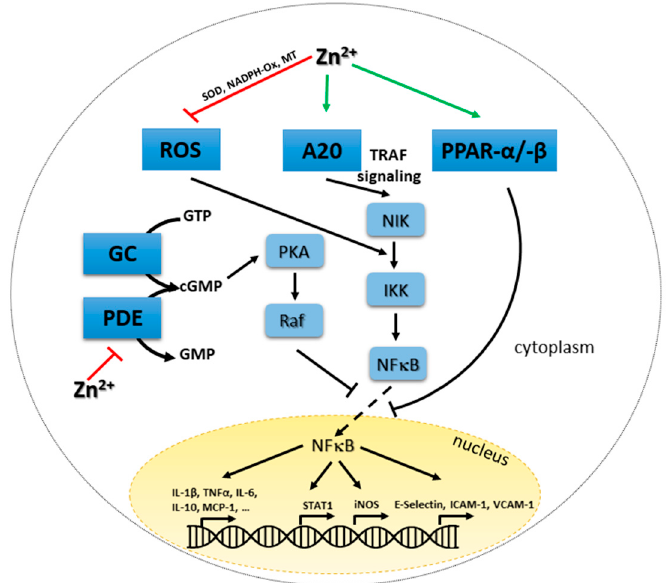
Figure 2. Complex impact of zinc on NF κ B-centered signaling as illustration of signaling pathways described in the text. Red T bar: inhibitory function of zinc, green arrow: activating function of zinc, black T bar: inhibition, black arrow activation. Abbreviations: cGMP: cyclic guanine monophosphate; GC: guanine cyclase; GMP: guanine monophosphate; GTP: guanine triphosphate; ICAM: intercellular adhesion molecule; iNOS: inducible nitric oxide synthase; IKK: I κ B kinase; IL: interleukin; MCP: monocyte chemoattractant protein; NIK: NF κ B-inducing kinase; NF κ B: nuclear factor (NF) κ B; PDE: phosphodiesterase; PKA: protein kinase A; PPAR: Peroxisome proliferator-activated receptor; ROS: reactive oxygen species; STAT: Signal transducer and activator of transcription; TNF: tumor necrosis factor; VCAM: vascular cell adhesion molecule.